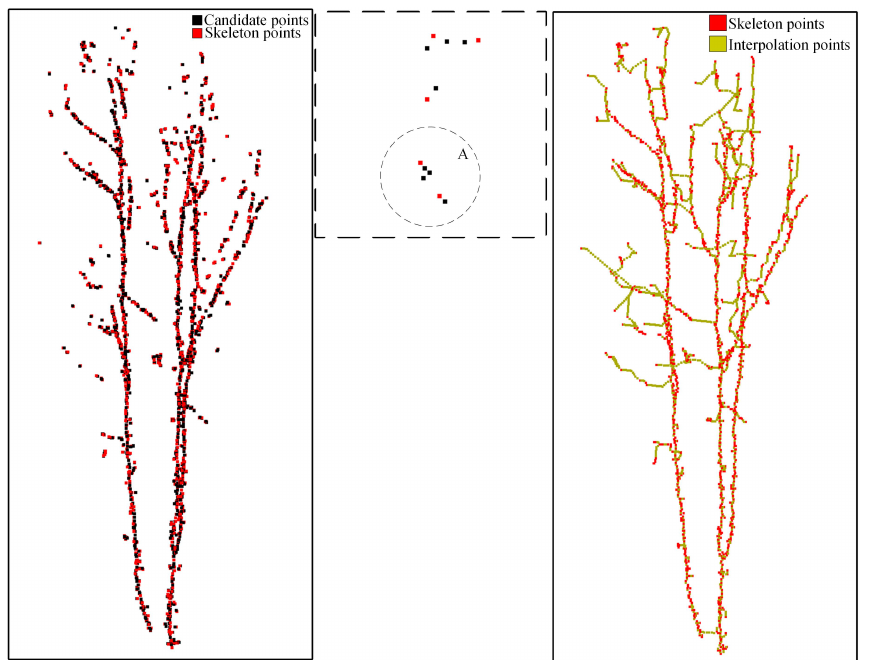
Figure 4. Results of the point